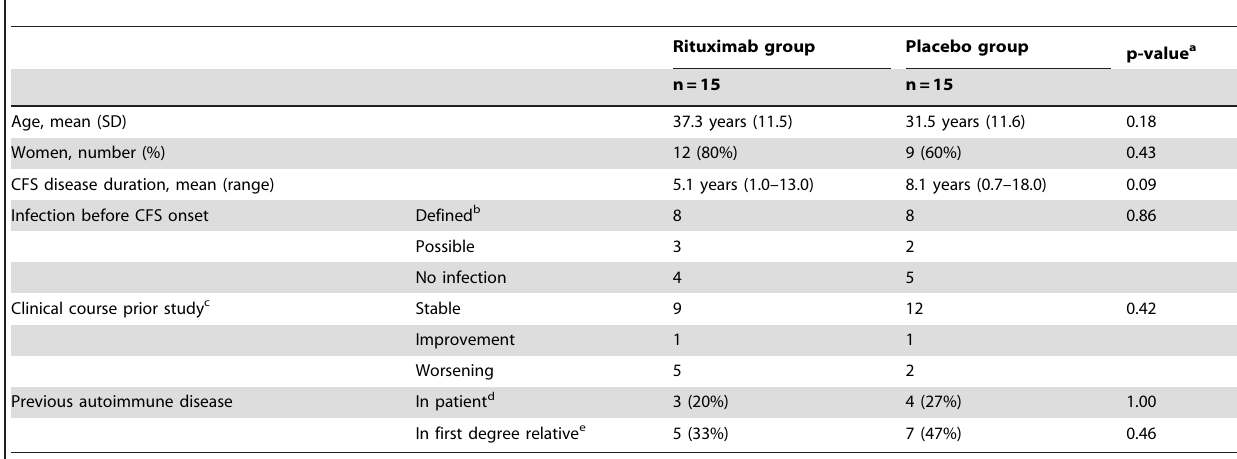
Table 1. Demographic and CFS disease characteristics for patients in the Rituximab and Placebo groups.